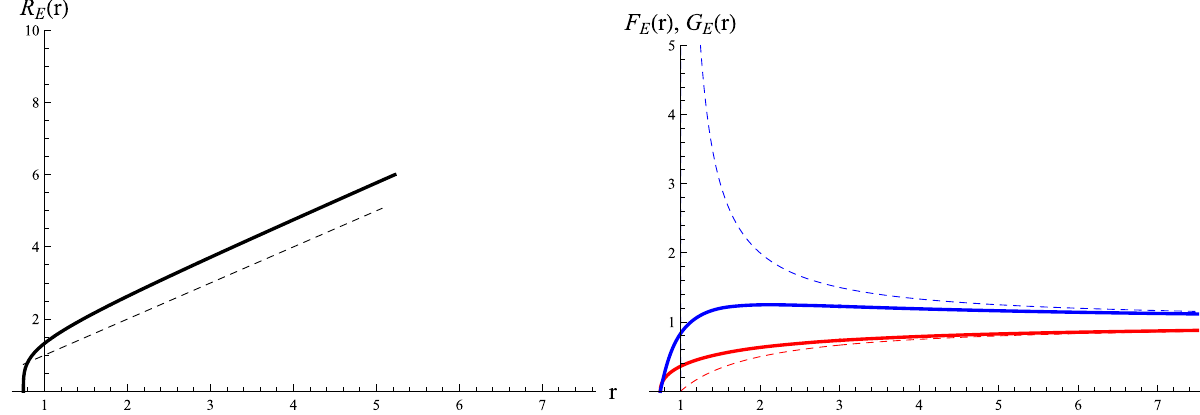
Fig. 6 Typical behaviors of R E (left), F E (right, red), and G E (right, blue), where we have chosen a = 3 and b = 2. Dashed curves corre- spond to R E (black), F E (red), and G E (blue), respectively, for a = 3 and b = 0 (i.e. the Schwarzschild solution). As r goes to infinity, the